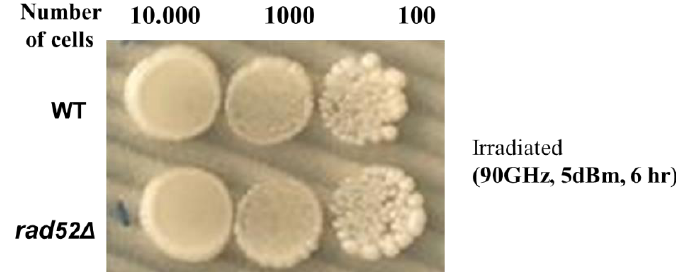
Figure 2. Representative image of the colony growth profiles of WT and ∆ rad52 cells with serial dilutions after (90 GHz) MMW irradiation at 5 dBm for 6 h. The cells were grown under physiological conditions at 30 ◦ C, over 3–4 days post-treatment period. Number of cells after serial dilutions are as indicated. Five independent experiments were performed. No statistically significant differences were found between the two examined strains.